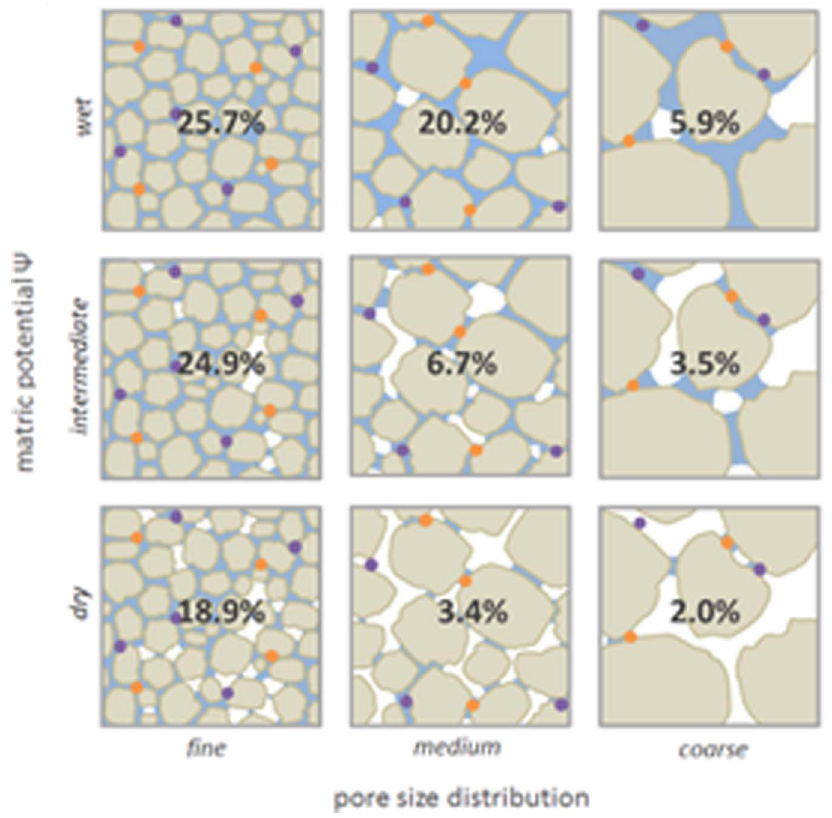
Figure 1. Schematic diagram of the experimental setup. Three matric potentials were combined with three sand particle size fractions with different pore size distributions, giving a total of nine treatments. In each box, the appropriate gravimetric water content of each treatment is indicated. Grain size, water distribution and bacterial cells (orange and purple) are indicated for illustrative purposes and are not based on actual microscopic visualization. Habitat connectivity decreases with decreasing matric potential and increasing pore size. In well-connected soils, (e.g. the treatments ‘‘wet’’ and/or ‘‘fine pores’’), bacterial species (orange and purple) often inhabit connected microhabitats/pore spaces, thereby allowing for completive interactions. Under less-connected conditions (e.g. low matric potential ‘‘dry’’ and coarse pores), microhabitats are discontinuous, thereby reducing competitive bacterial interactions.